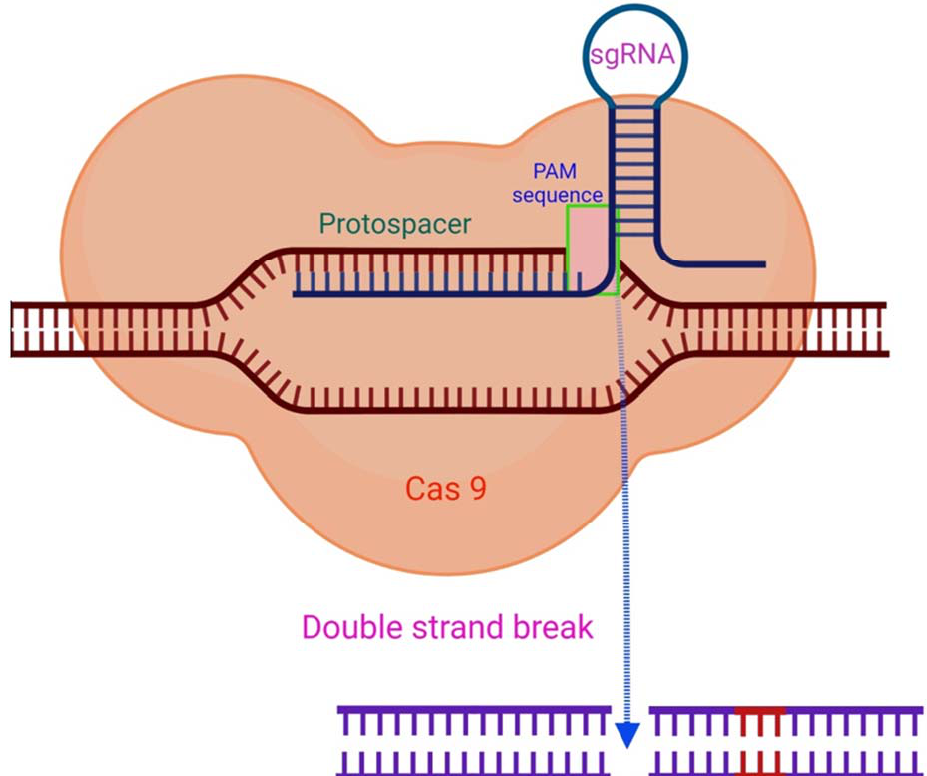
Figure 2. The CRISPR/Cas9 mechanism. By complementary base pairing, the sgRNA recognizes the target sequence (protospacer) in a host organism’s genome. The Cas9 nuclease causes a DSB in a PAM sequence region with a NGG (any nucleobase followed by two guanine nucleobase) sequence at the 3 (cid:48) position. Adapted from [47] and generated with BioRender